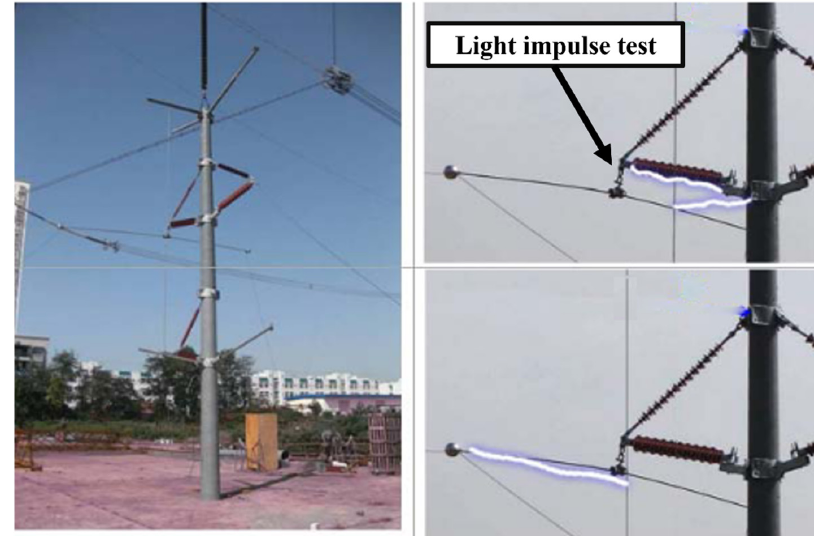
Figure 24. Experimental setup for testing [90].